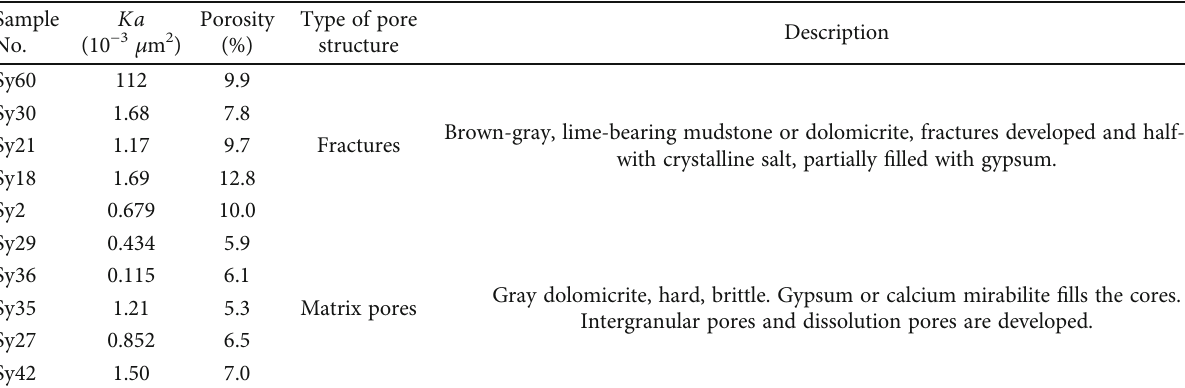
Table 2: Classi fi cation of the core samples ’ storage and fl ow spaces.